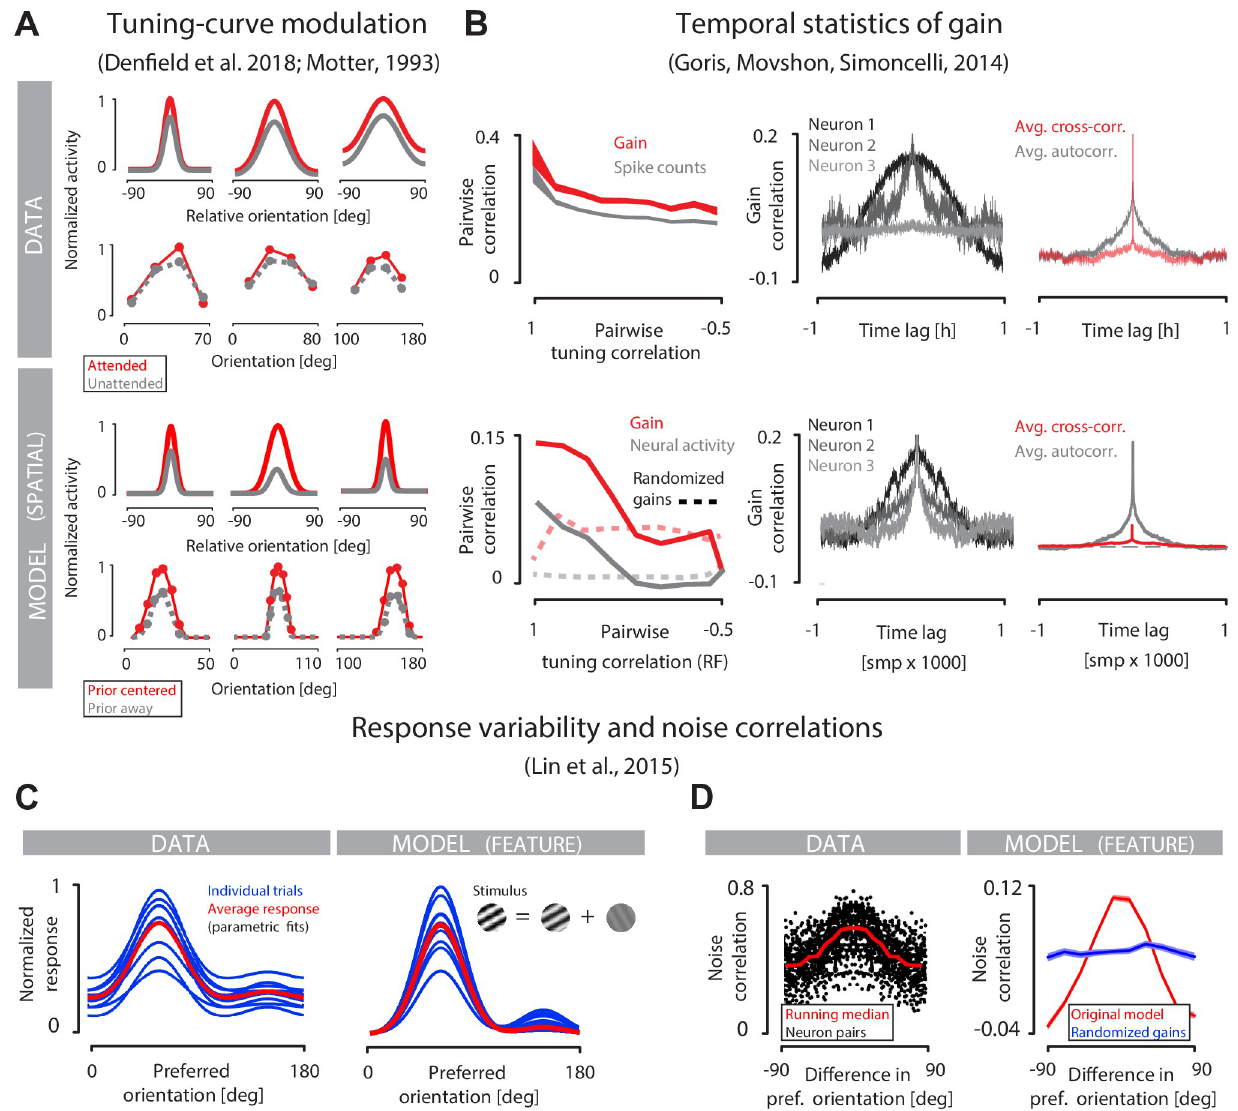
Fig 6. Comparison of adaptive coding model to experimental data. (A) Tuning curves of individual neurons in macaque V1 in an attended (red) and unattended (gray) conditions. We display parametric fits to tuning curves centered at the preferred orientation (top panel, top row; replotted from [63]), as well as raw tuning curves (top panel, bottom row; replotted from [62]). Model reproduces the modulation of tuning curves (bottom panel; rows correspond to rows in the top panel; see main text for details). (B) Pairwise correlation of internal gain signals (red) and neural activity (gray) as a function of tuning correlation in macaque V1 (top left) is reproduced by the model (bottom left; see main text). Dashed lines denote gain correlations when optimal gain values are randomly reshuffled across the population. Measured gain autocorrelation functions for three example neurons (top middle) span a range of timescales similarly to optimal gain dynamics in the model (bottom middle). Average gain autocorrelation function (gray) and average pairwise gain cross-correlation function (red) are reproduced by the model (data figures—courtesy of Robbe Goris [1] top right; model bottom right). (C) Variation of V1 population responses to individual presentations of a mixture of oriented gratings (left, blue lines; data panels in (C) and (D) are reproduced from [65]) fluctuates around the average response (left, red line). Lines depict parametric fits to data. Model optimized for orientation discrimination generates similar pattern of variability (right). (D) Noise correlations in V1 depend on the difference in preferred orientation (left, red line denotes the running median). Average noise correlations in the model display similar dependence (right, red line), which disappears after shuffling of neural gains (right, blue